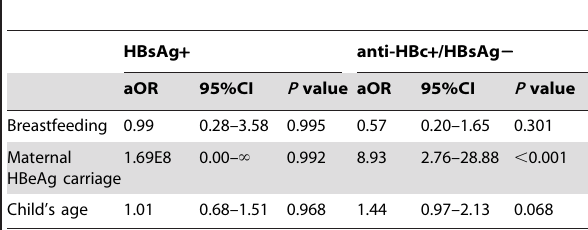
Table 3. Logistic regression analyses for the prevalence of HBsAg or anti-HBc in the